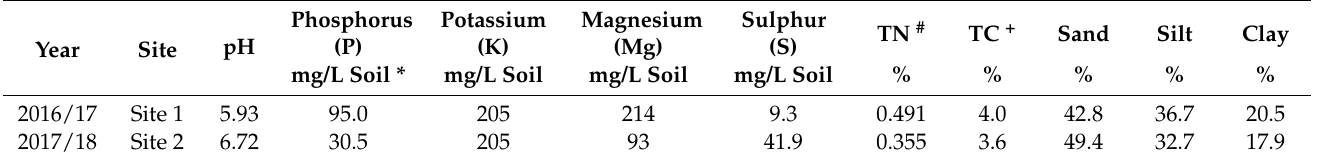
Table 1. Soil test (15 cm) prior to spring barley